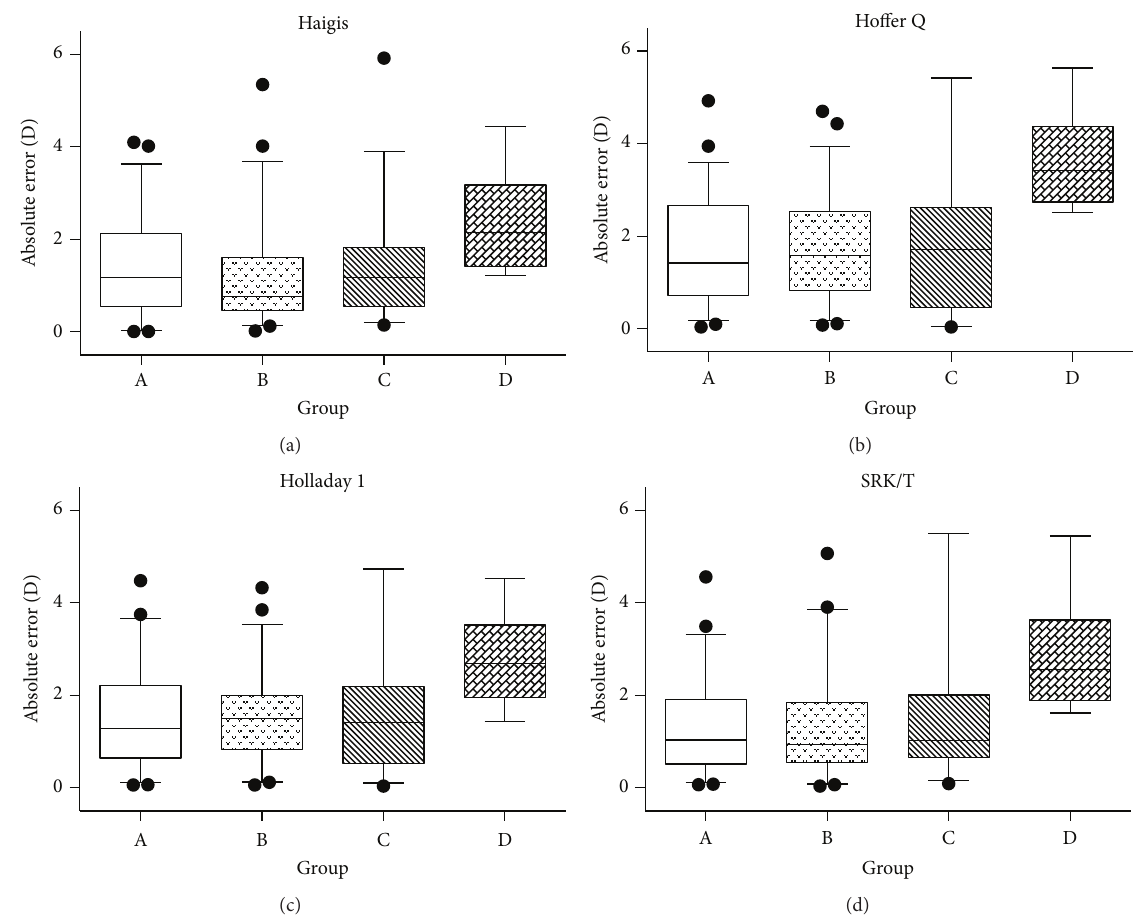
Figure 2: Subgroup analysis: absolute errors for Groups A–D calculated using the four IOL formulas. All four formulas were least accurate for eyes within Group D. The overall median absolute error was significantly higher for Group D than for Groups A, B, and C ( 𝑃 = 0.002 , 0.002 and 0.010, resp., as determined by a repeated-measures ANOVA test). The whiskers indicate 5 and 95 percentile of absolute errors in each group. D,